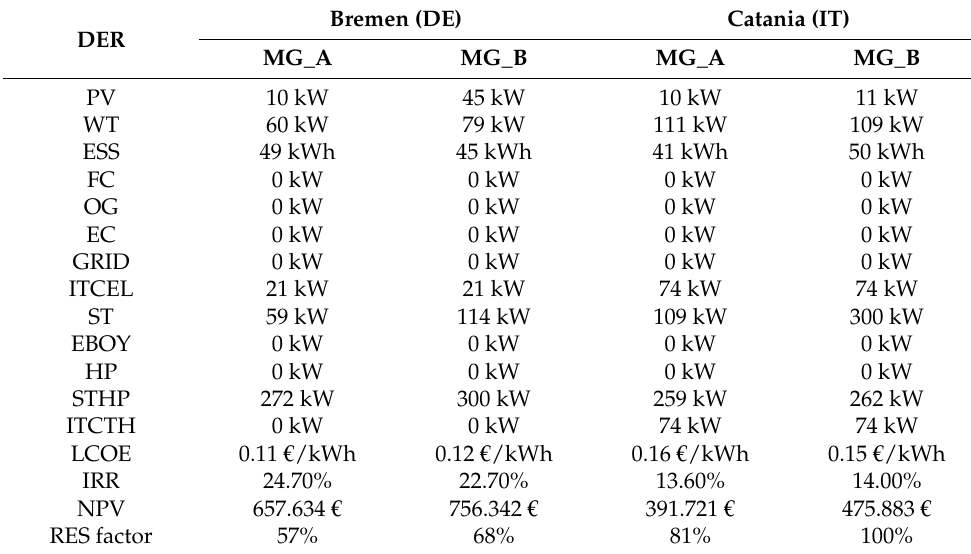
Table 4. Size of DER, key financial ratios for isolated CHP-MMG without hydrogen refilling (25 years project lifetime, discount rate of 5%, off-grid, no daily refilling of hydrogen).